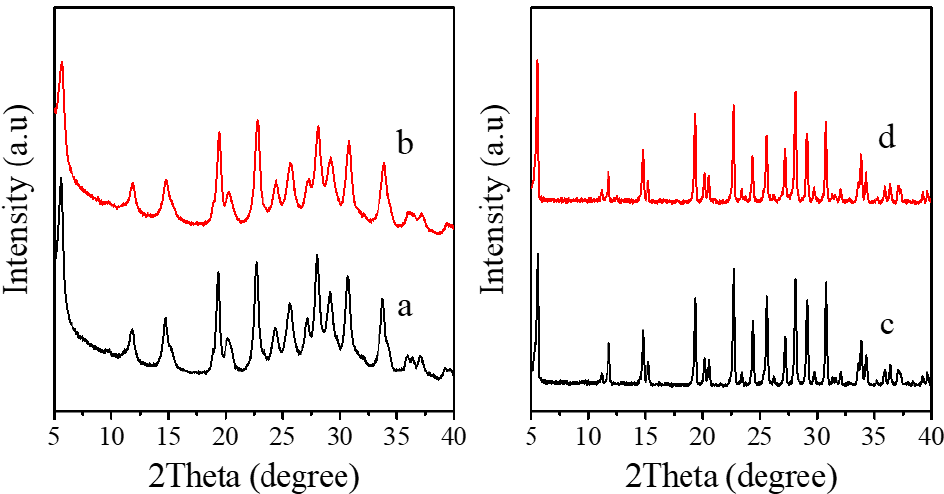
Figure 1. XRD patterns of ( a ) as-synthesized Fe-LTL-N, ( b ) calcined Fe-LTL-N, ( c ) as-synthesized Fe-LTL-C, ( d ) calcined Fe-LTL-C, respectively.